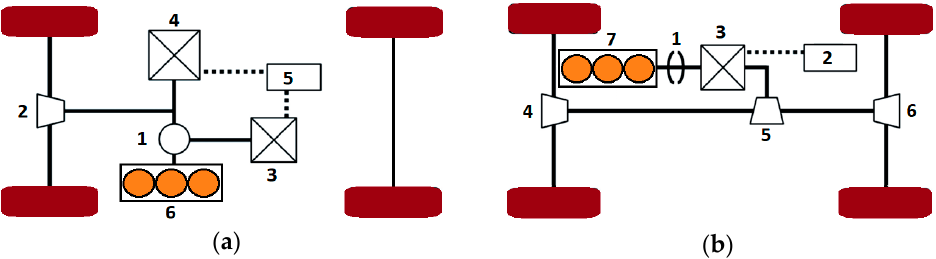
Figure 2. Hybrid power split drivetrain: ( a ) FWD: 1, Power Split Device; 2, Diff; 3, MG1; 4, MG2; 5, battery; 6, ICE. ( b ) AWD: 1, Clutch; 2, Battery; 3, MG; 4, 5, 6, Diff; 7,